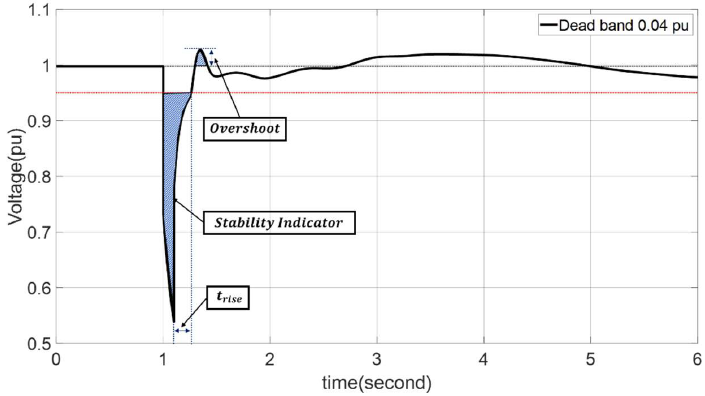
Figure 10. Performance indicators of the simulation result.